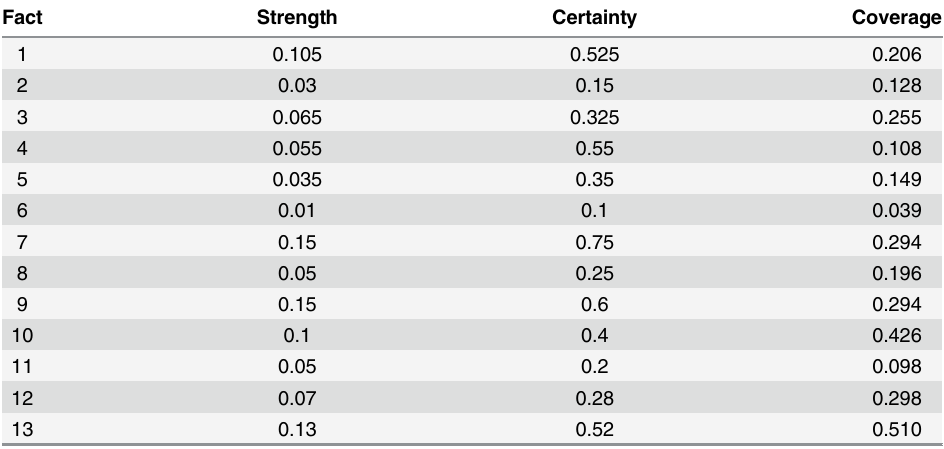
Table 9. The Strength, Certainty, and Coverage, Voting result.